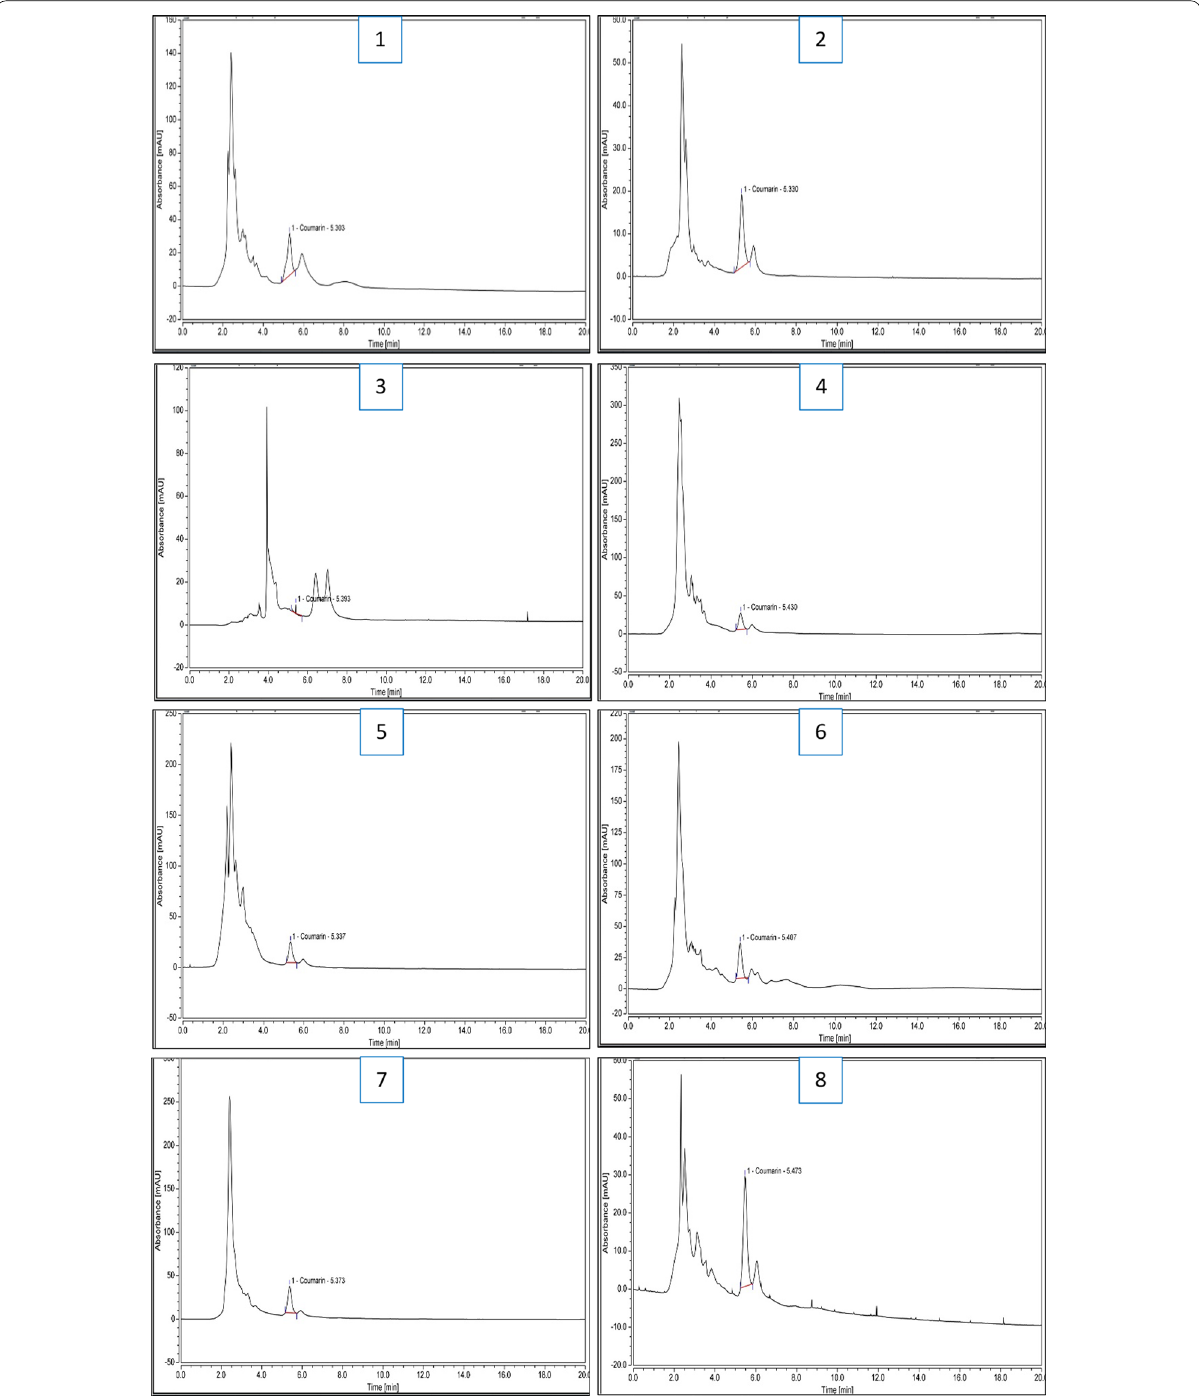
Fig. 8 HPLC chromatograph shows the peak of coumarin from leaf callus of L. barbarum cultured on MS callus proliferation medium containing 552.60 µM TDZ under total darkness. 1 Mother plant (grown in open field). 2 Callus culture without additives (control). 3 Callus culture with = = = 381 μM chitosan. 4 Callus culture with 763 μM chitosan. 5 Callus culture with 1526 μM chitosan. 6 Callus culture with 381 μM cinnamic = = = acid. 7 Callus culture with 763 μM cinnamic acid. 8 Callus culture with 1526 μM cinnamic acid. 9 Callus culture without additives (control). = = = 10 Suspension culture with 381 μM chitosan. 11 Suspension culture with 763 μM chitosan. 12 Suspension culture with 1526 μM chitosan. = = = 13 Suspension culture with 381 μM cinnamic acid. 14 Suspension culture with 763 μM cinnamic acid. 15 Suspension culture with 1526 μM = = = cinnamic